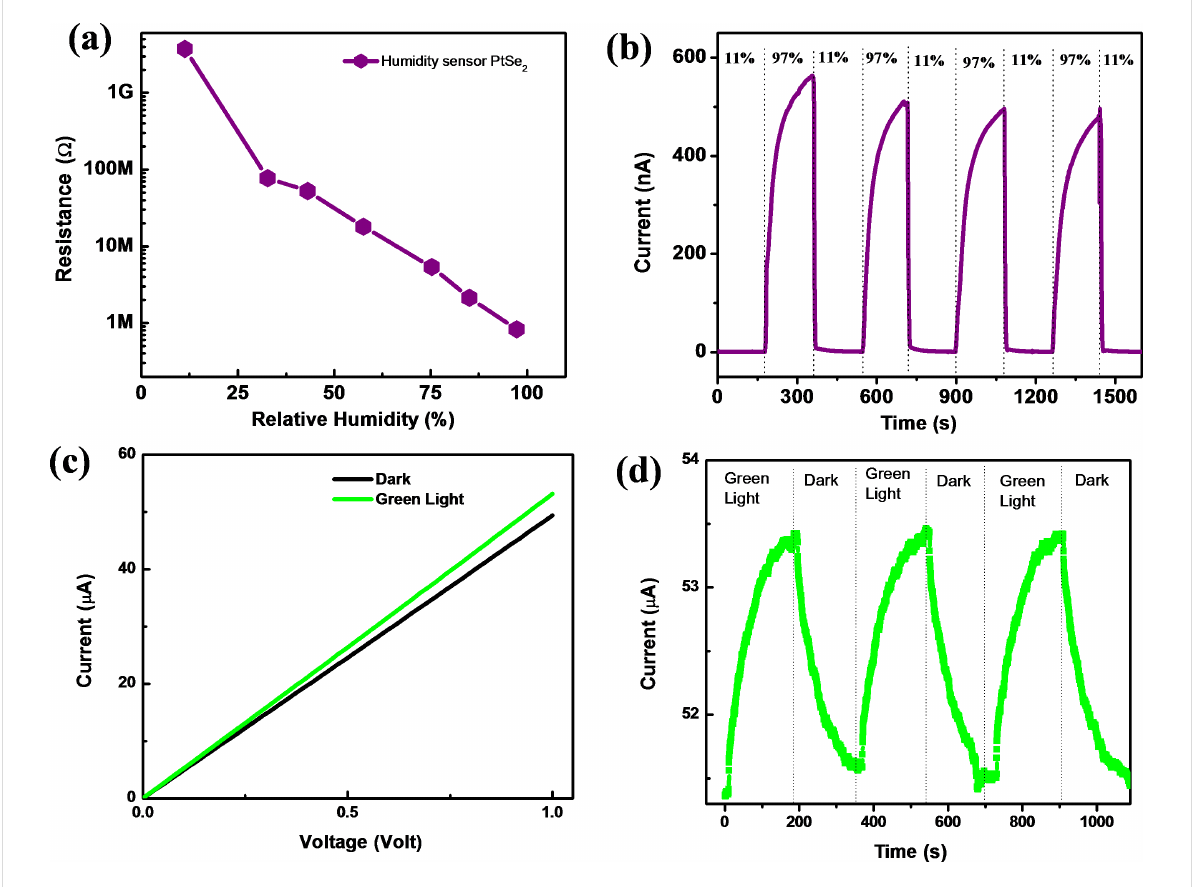
Figure 7: PtSe 2 nanosheet based humidity sensor: (a) Typical resistance versus relative humidity plot and (b) current–time ( I – t ) plot taken after switching 11% RH and 97% RH. The photodetector application of PtSe 2 nanosheets: (c) I – V in dark conditions and with green LED light and (d) typical I – t cycle when the LED is on and off, showing a favourable